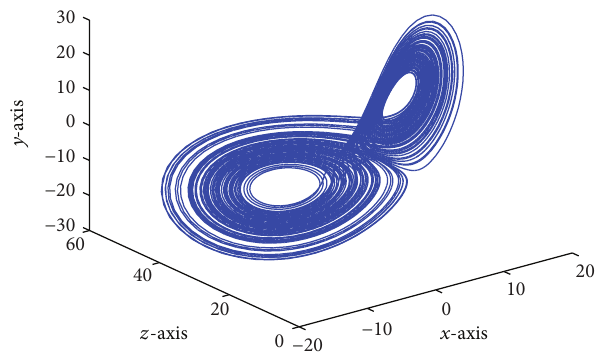
Figure 1: The nonlinear dynamics of the network.